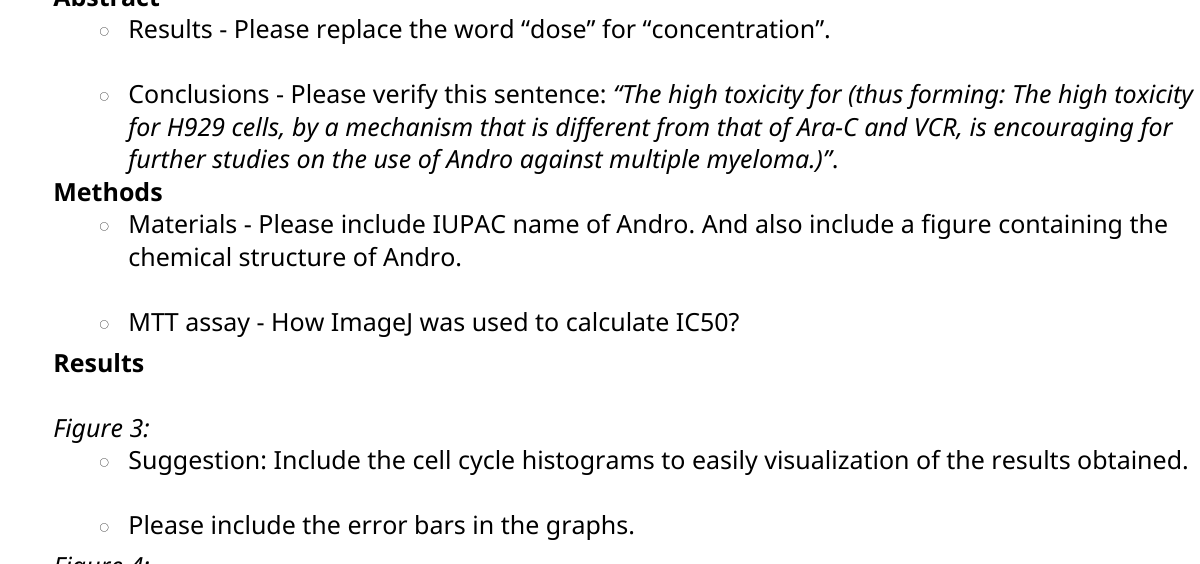
Suggestion: Include the dotplot of cells 48h after the treatment.